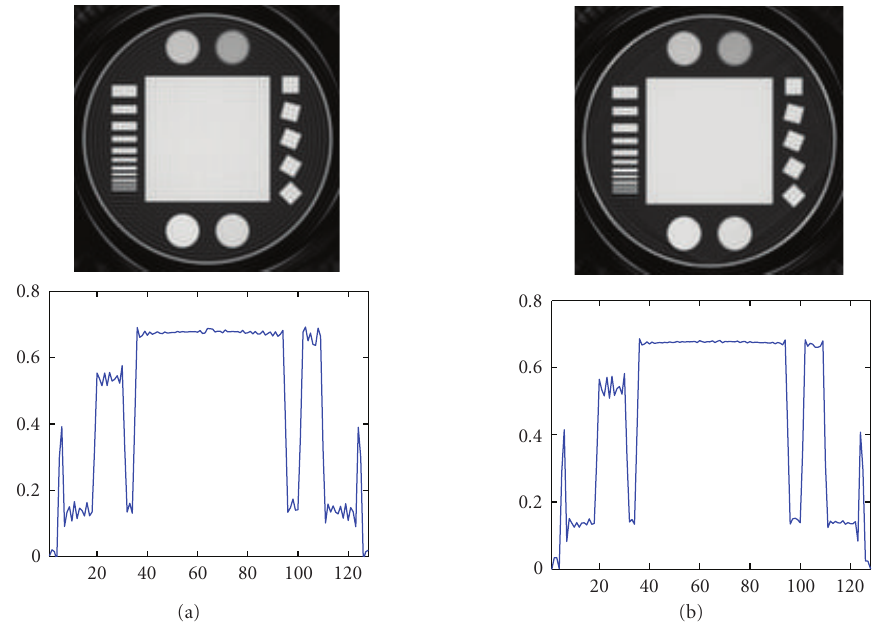
Figure 8: Reconstruction results of a spiral scan through (a) direct reconstruction and (b) leakage reduction reconstruction.